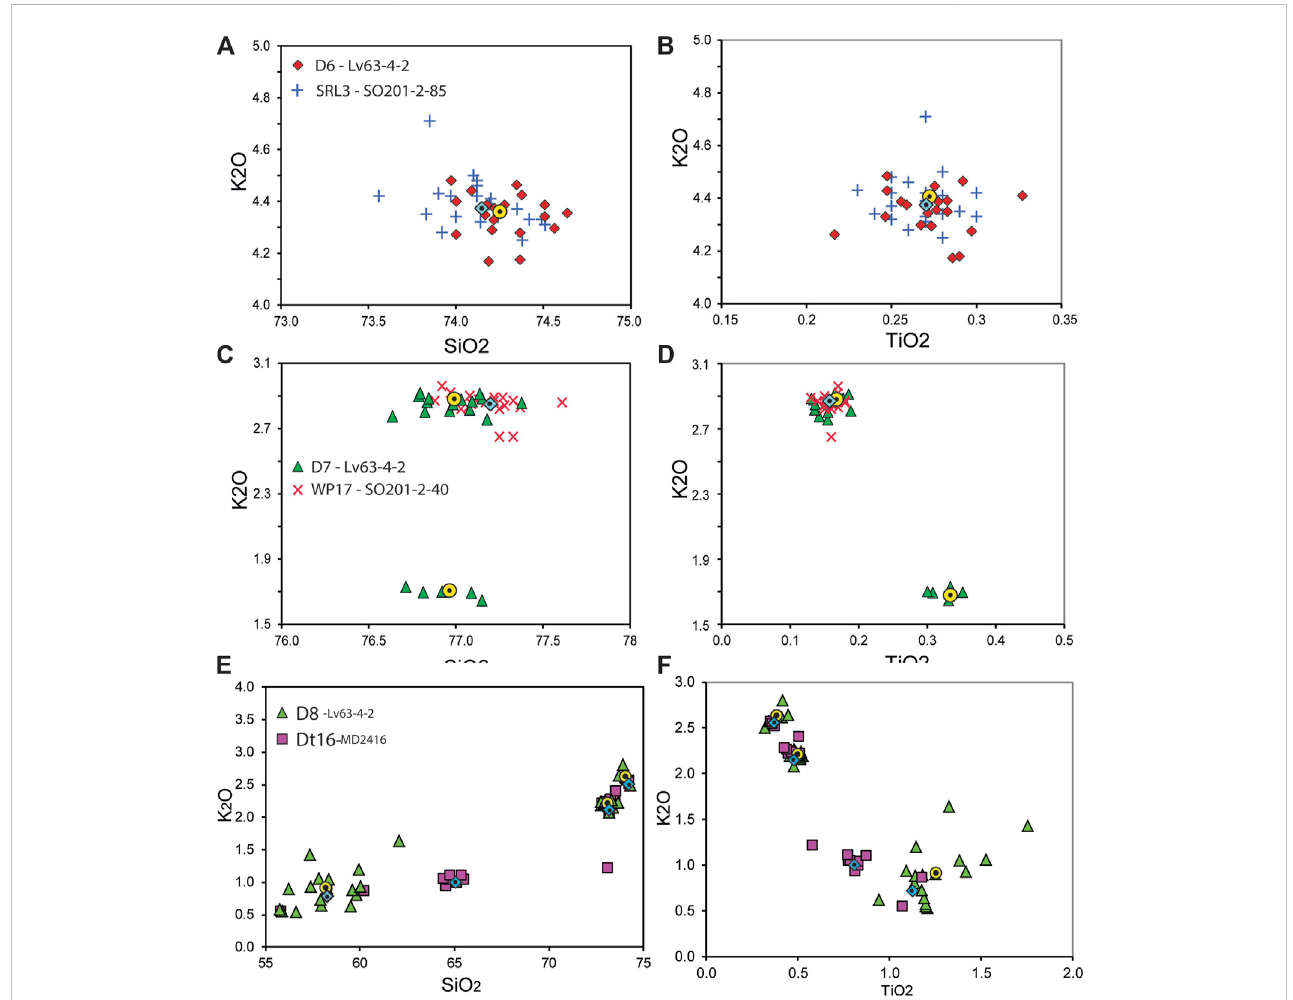
FIGURE 7 Comparison of volcanic glass compositions from different tephra (SiO 2 -K 2 O and TiO 2 -K 2 O diagrams). (A,B) Comparison of glass from tephra D6 with glass from distal tephra SRL3 (Bering Sea) (Derkachev et al., 2018); (C,D) Comparison of glass from tephra D7 with glass from distal tephra WP17 (Derkachev et al., 2020); (E,F) Comparison of glass compositions from tephra D8 with tephra Dt16 (MD2416). The reference data for the samples are provided in Supplementary Table